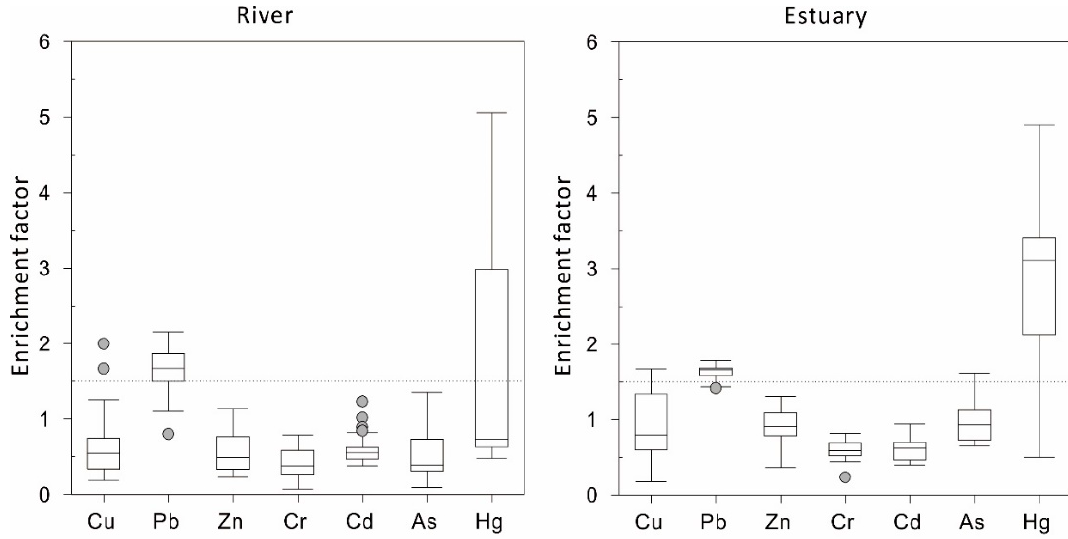
Figure 4. The enrichment factors (EF) of trace metals in the river and estuary sediments.